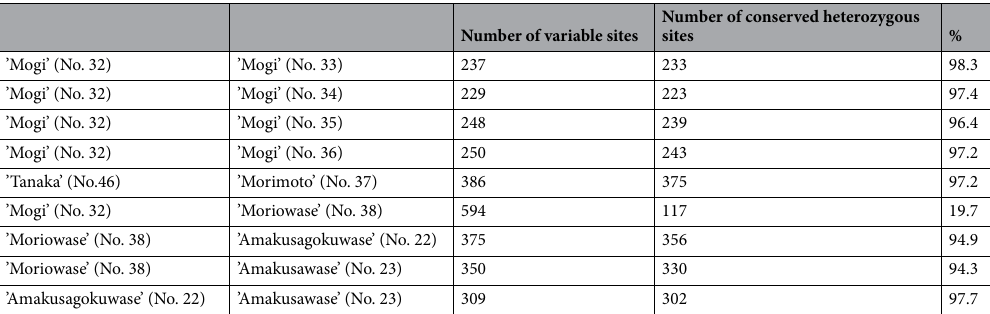
Number of variable sites